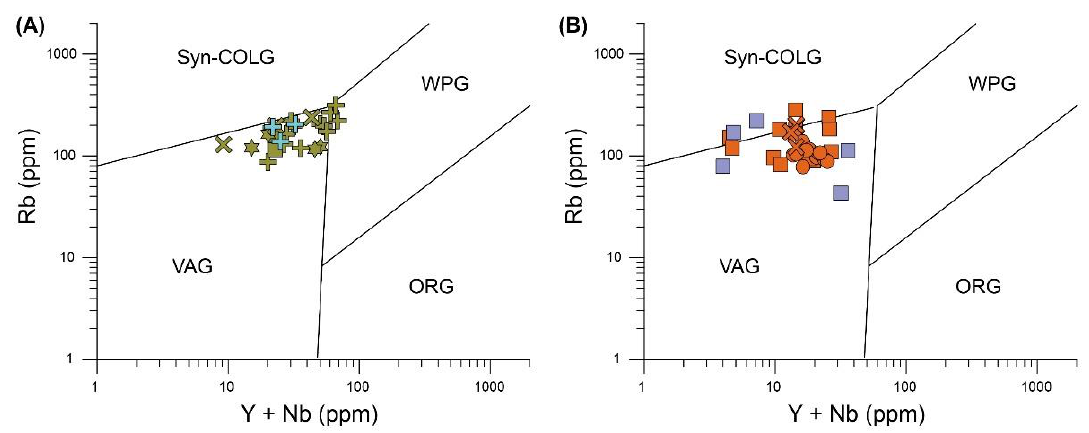
Figure 11. Rb versus (Y + Nb) tectonic discrimination diagram for ( A ) the Middle Paleoproterozoic orthogneisses, and ( B ) Late Triassic granite and Early Jurassic granitic rocks in the Jangsu-gun area. VAG, volcanic arc granites: ORG, ocean ridge granites; WPG, within-plate granites; syn-COLG, syn-collision granites. Symbols are as in Figure 6.